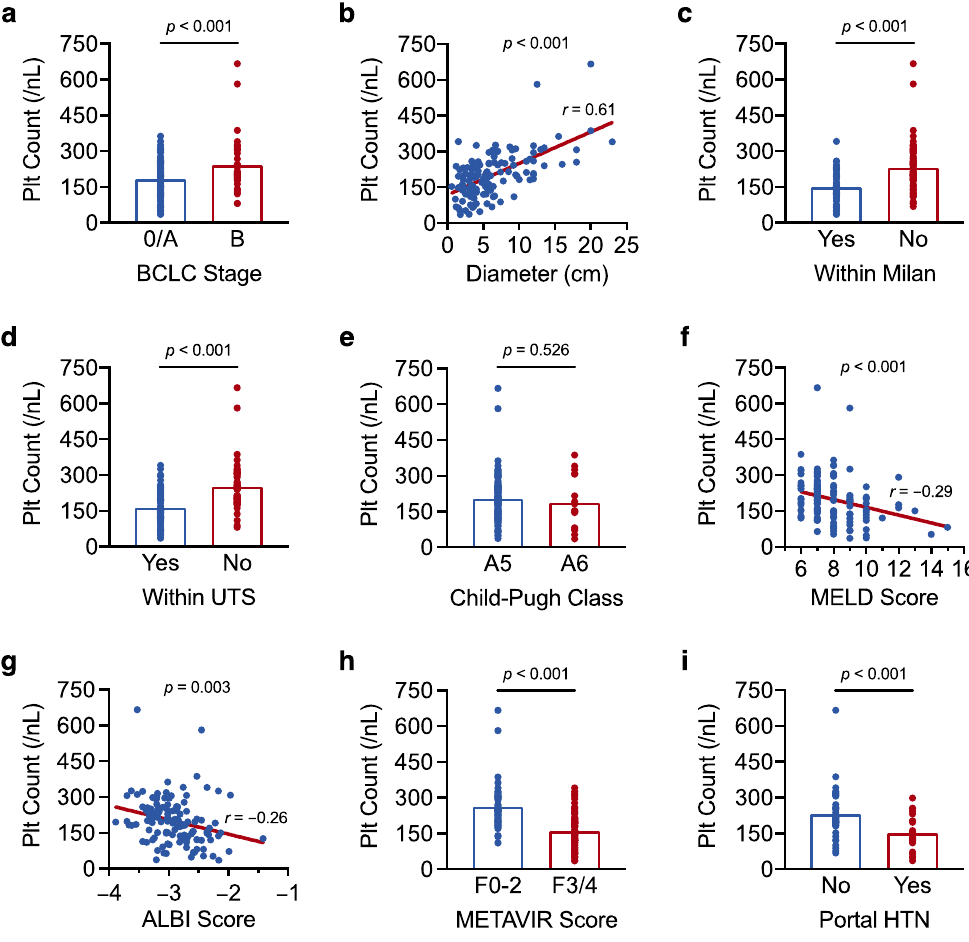
Figure 2. Platelet count correlates with tumour burden and liver disease severity in resectable HCC. ( a – i ) Results of a linear regression analysis showing the association of platelet count